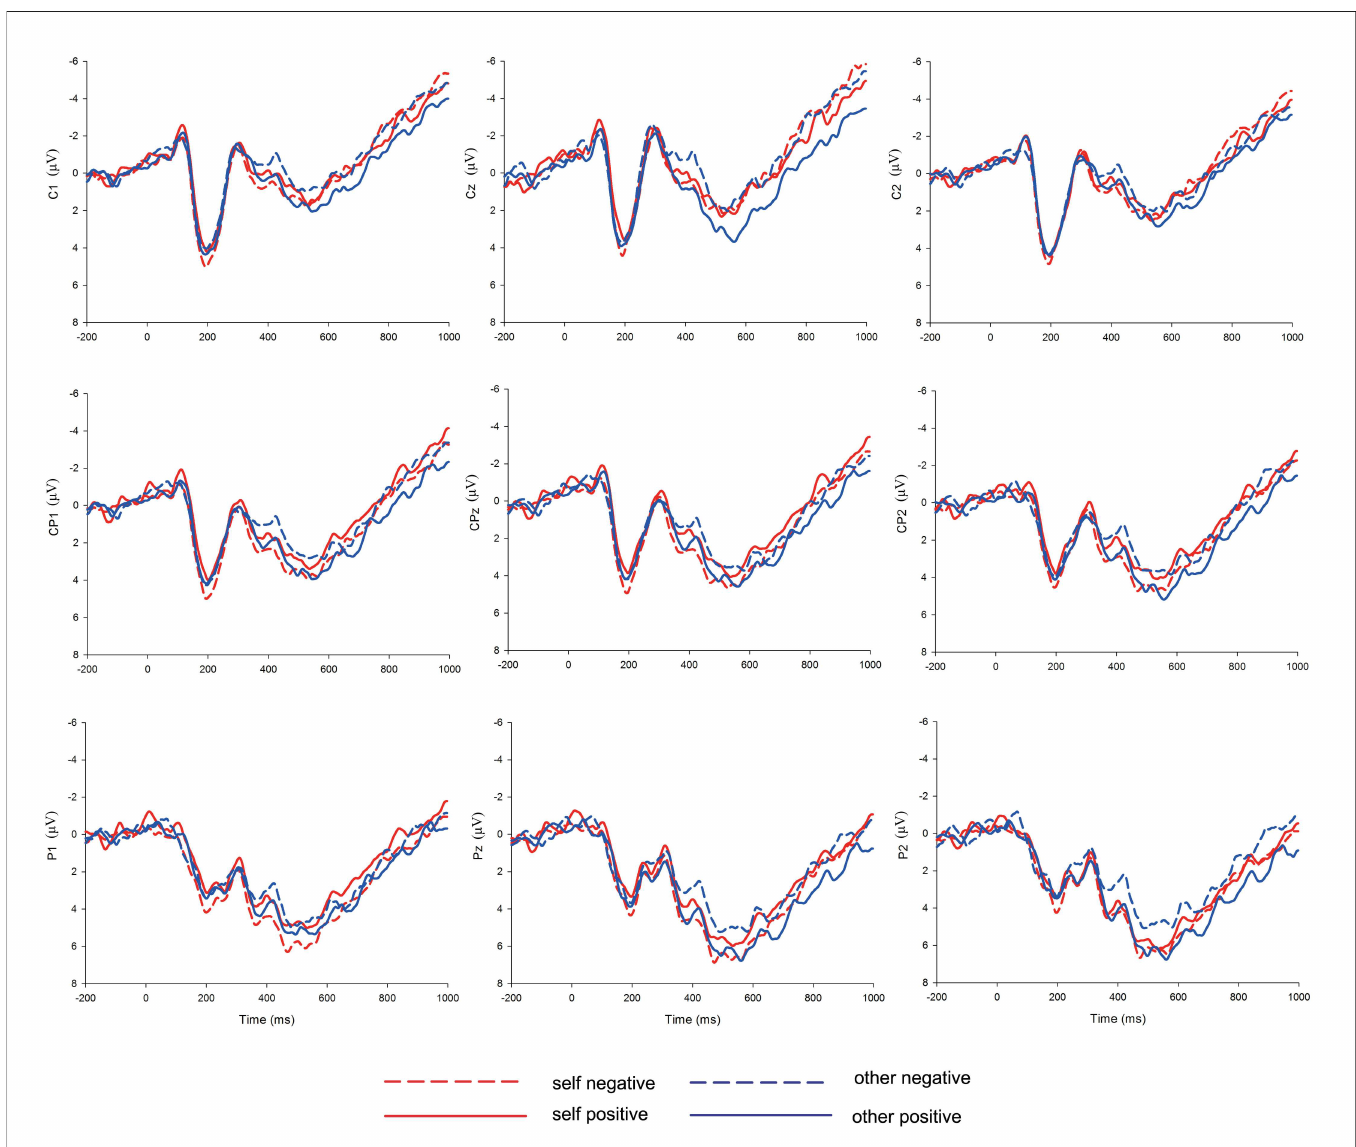
Fig 2. ERP Responses at the Nine Central-Posterior Electrodes, Time-Locked to the Onset of Object Nouns.